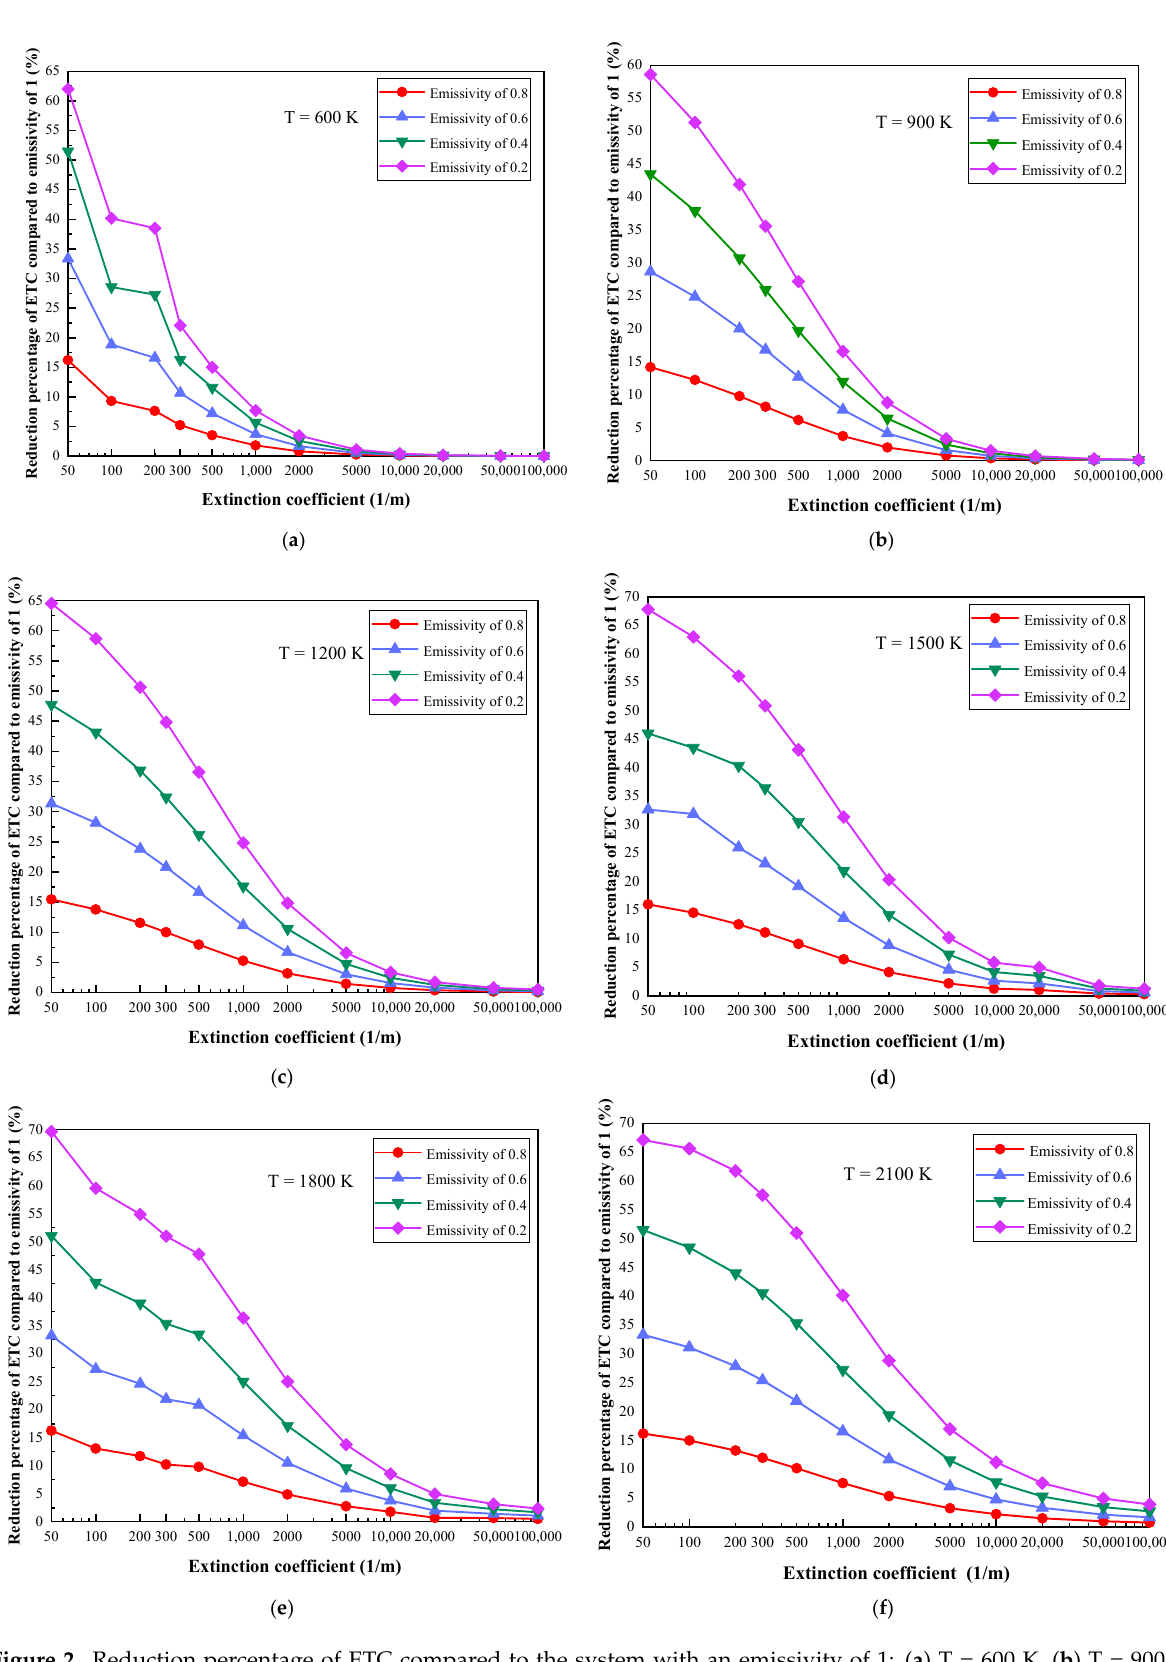
Figure 2. Reduction percentage of ETC compared to the system with an emissivity of 1: ( a ) T = 600 K, ( b ) T = 900 K, ( c ) T = 1200 K, ( d ) T = 1500 K, ( e ) T = 1800 K, ( f ) T = 2100 K. Under the premise that the boundary temperatures are 600 K and 2100 K, and the emissivity values of the coupling interface are 1 and 0.2, the temperature diagrams with changes in the extinction coefficient are shown in Figure 3. With the increase in the extinc- tion coefficient, the dispersion behavior of temperature becomes more obvious. Figure 4 shows the change in temperature diagrams with the boundary temperatures at extinction coefficients of 50 m −1 and 100,000 m −1 , respectively. When the extinction coefficient is 50 m −1 , the temperature change is almost linear; however, when the extinction coefficient is greater than 5000 m −1 (optical thickness ≥ 50), the dispersion behavior of the temperature is basically the same. The reason can still be explained by the optical thick medium. When the extinction coefficient is large, the con- duction and radiation coupling heat transfer process inside the material is considered a heat diffusion process. Although, for materials with small extinction coefficients, espe- cially in high-temperature environments, the radiation penetration distance is long and the radiation heat transfer is dominant; thus, the manifestation of the temperature dia- gram is different from that of materials with large extinction coefficients.